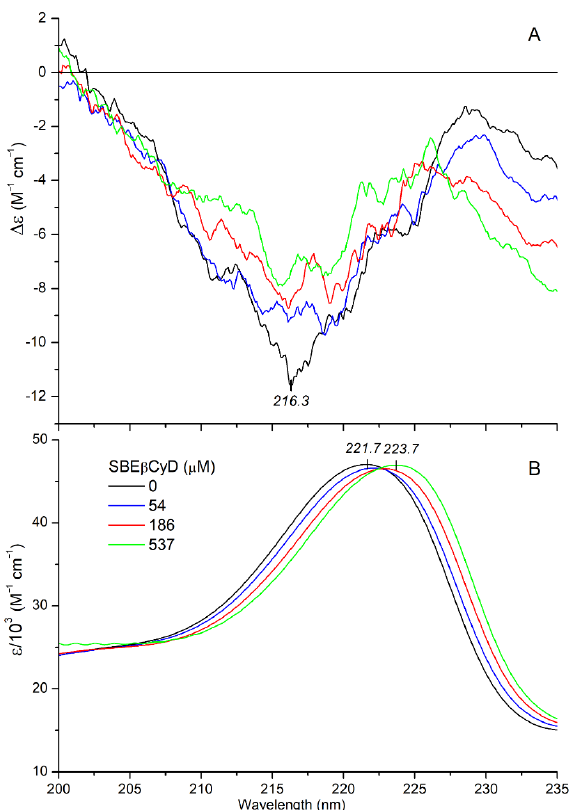
Figure 7. Far-UV CD ( A ) and absorption ( B ) spectrum of 24 μ M mitragynine measured in aqueous HCl solution (pH ~ 3) at increasing concentrations of SBE β CyD. HCl solution (pH~3) at increasing concentrations of SBE β